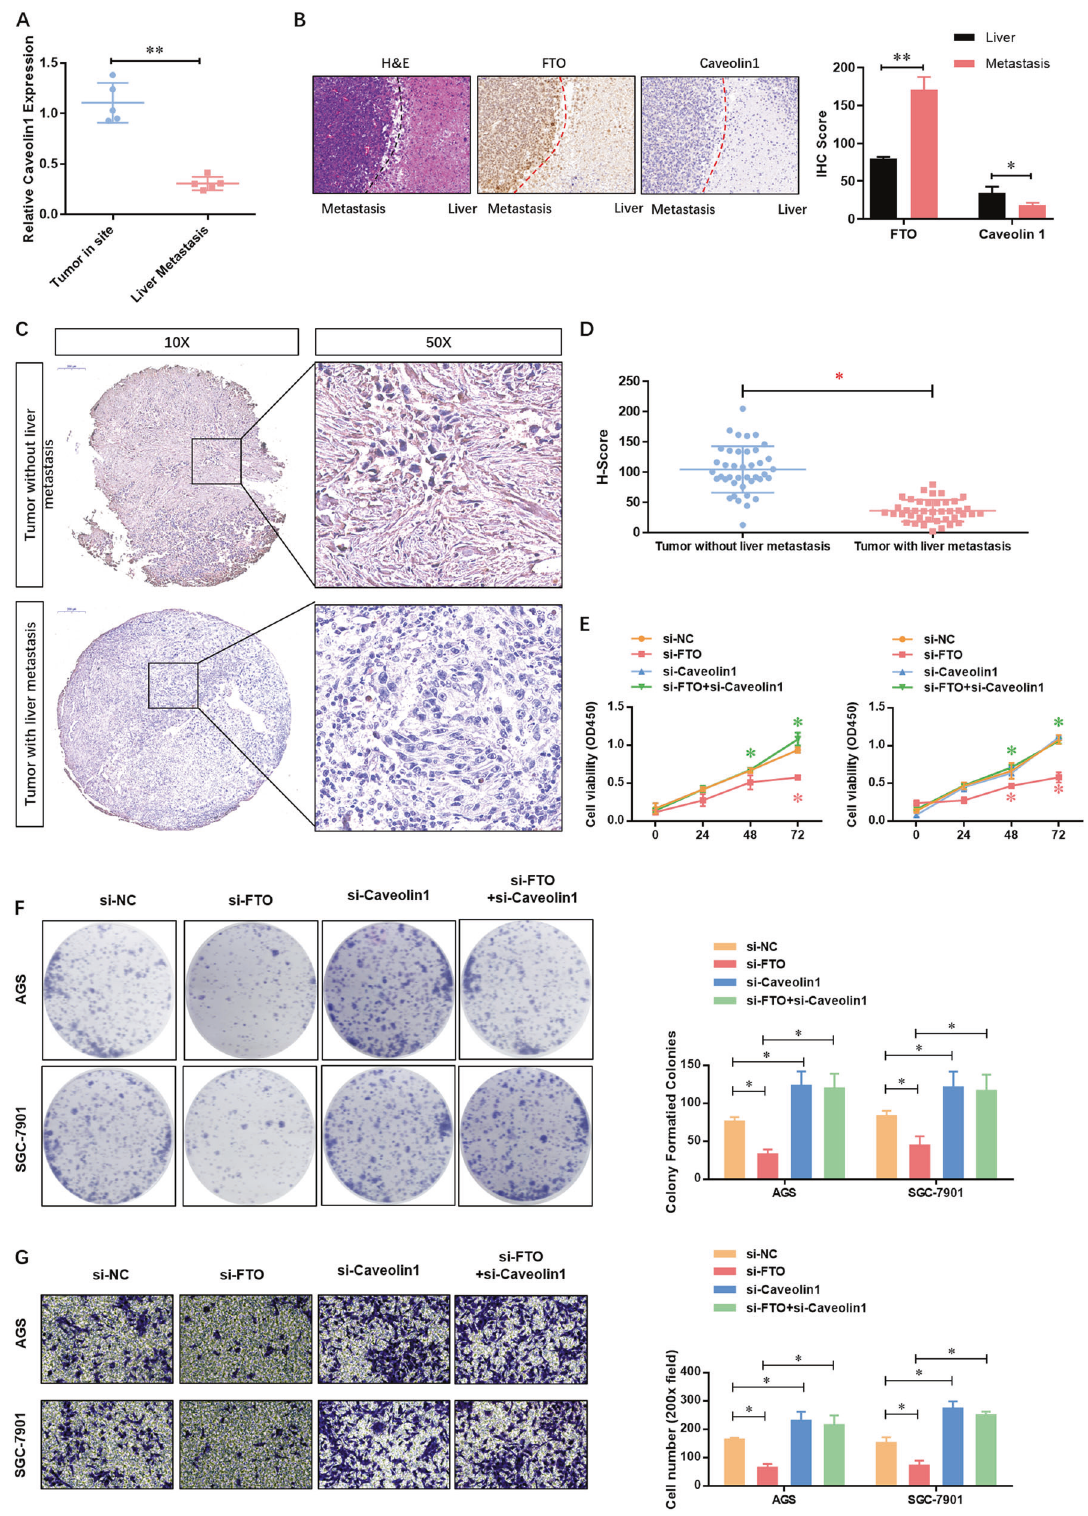
Fig. 5 FTO depletion impairs the proliferation, migration, and invasion of GC cells via inhibiting caveolin-1. A The expression of caveolin-1 at the mRNA level in the tumor and liver metastasis tumor was analyzed by qRT-PCR. B The expression of caveolin-1 at the protein level in the tumor and liver metastasis tumor was analyzed by IHC. C The expression of caveolin-1 at the protein level in the GC tissue microarray consisting of 90 cases was analyzed using IHC, and D quantitative analysis was performed using the IHC data. E The effect of caveolin-1 depletion on the cellular viability of AGS and SGC-7901 cells with or without FTO depletion was analyzed by CCK-8 assay. F The effect of caveolin-1 depletion on the proliferation of AGS and SGC-7901 cells with or without FTO depletion was analyzed by colony formation assay. G The effect of caveolin-1 depletion on the invasion of AGS and SGC-7901 cells with or without FTO depletion was analyzed by transwell assay. N = 3, * p <0.05, ** p <0.01 compared with the indicated group. Cell Death and Disease (2022)